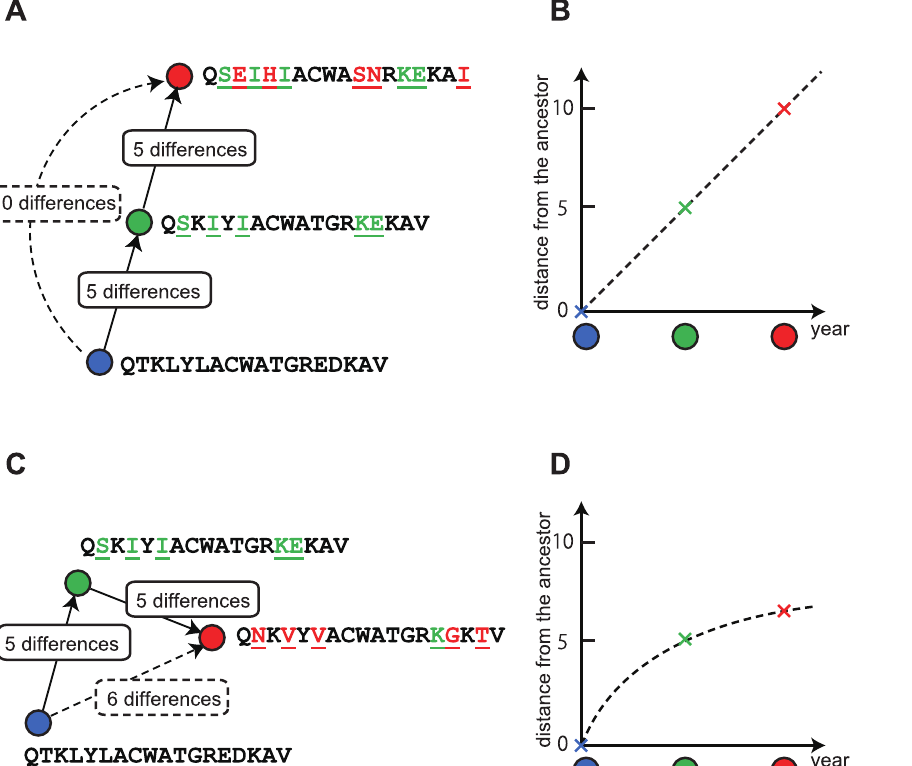
Figure 2. Two distinct patterns of amino acid substitutions that produce different spatial arrangements of viruses. (A) The straight arrangement of viruses. If a series of amino acid substitutions all occur in different positions, then the distance from an ancestor to a mutant should be proportional to the number of substitutions (B). These independent substitutions make a straight arrangement of viruses on the map. (C) The curved arrangement of viruses. If amino acids at particular positions were substituted more than once, the distance from an ancestor to a mutant should be less than the number of substitutions (D). These concentrated substitutions at the same amino acid positions make a curved arrangement of viruses. In both panels, viruses are represented by circles, with illustrative examples of their amino acid sequences and substitutions on them.